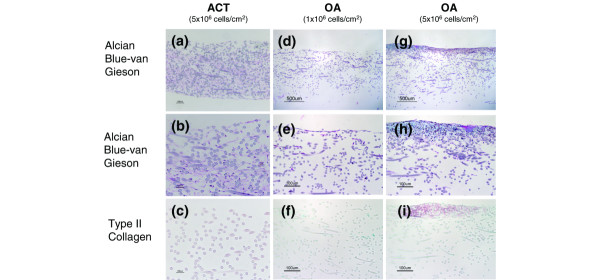
Histology of cell-seeded scaffolds. The figure shows scaffolds seeded with chondrocytes from one representative autologous chondrocyte transplantation (ACT) donor (a–c) and one osteoarthritis (OA) donor (unaffected) at two different cell seeding densities, 106 cells/cm2 (d–f) and 5 × 106 cells/cm2 (g–i). Accumulation of proteoglycans is shown with Alcian blue/van Gieson stain and the presence of type II collagen is indicated by red staining within the scaffold. Panels (b), (e) and (h) are higher magnifications of portions of (a), (d) and (g), respectively.